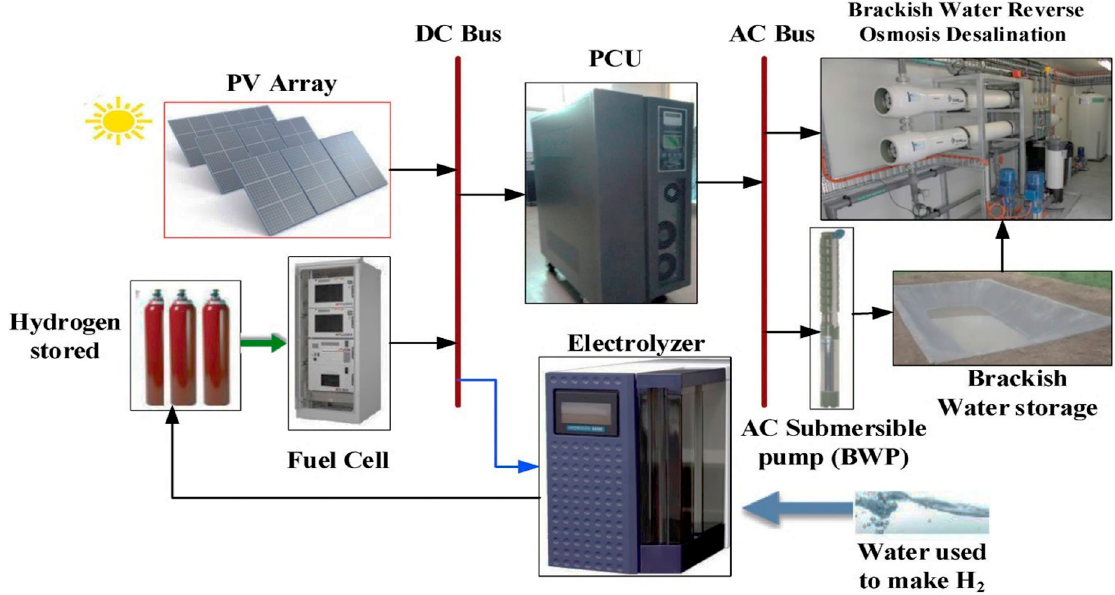
Figure 6. Block diagram of the hybrid desalination system [78], reused with permission from Elsevier (license number 5491420656683).